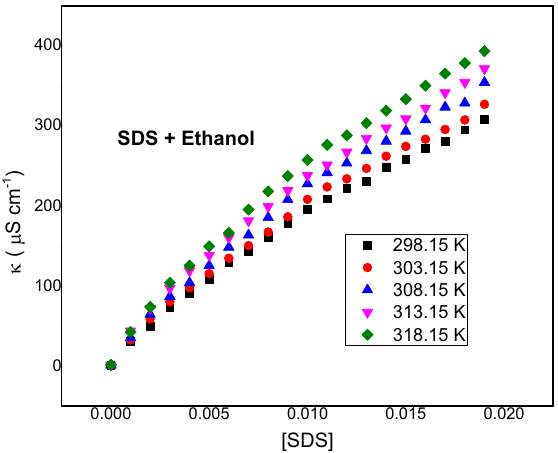
Figure 2. Specific conductance of SDS in ethanol at different temperatures .